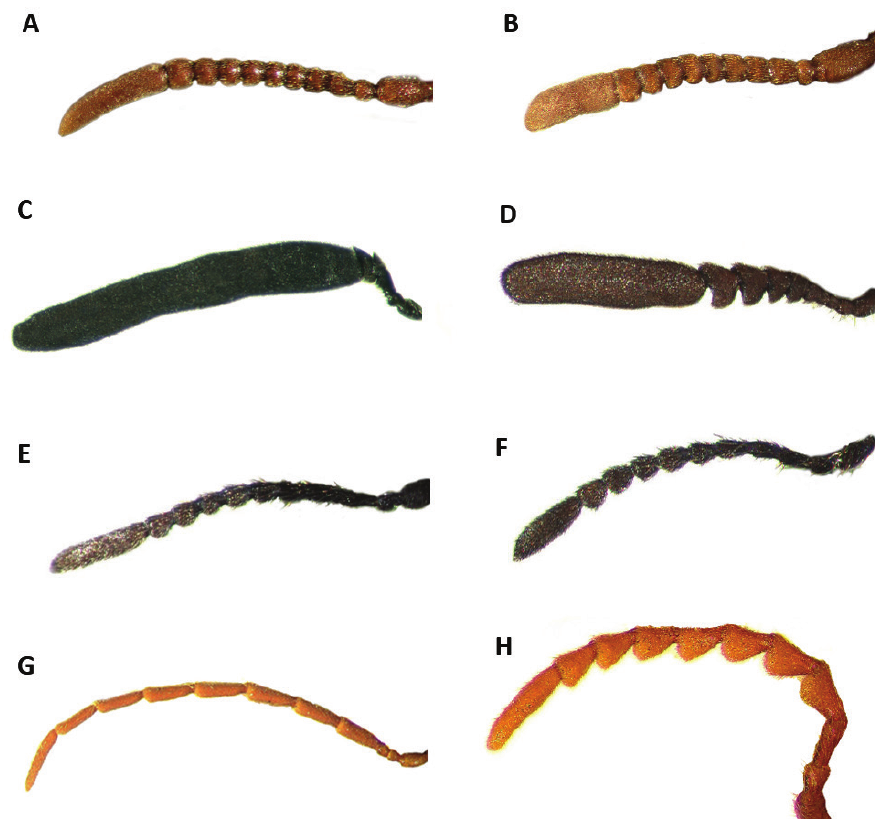
Figure 10. Antennae of: A Lecontella gnara (male) B Lecontella striatopunctata (male) C Monophylla californica (male) D Monophylla terminata (female) E Onychotillus cubana (male) F Onychotillus vittatus